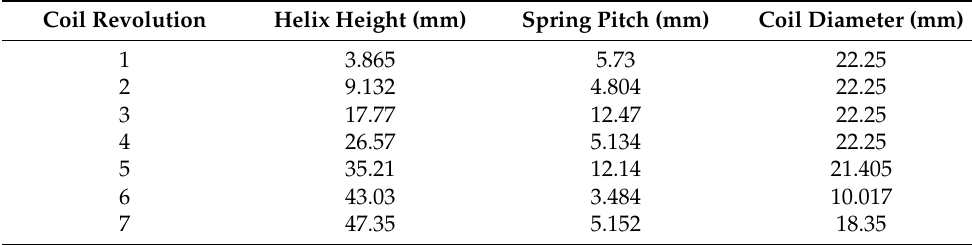
Figure 2. ( a ) The beehive spring sample. ( b ) The FE model of the beehive spring using the Timoshenko beam element. Table 1. The geometric properties of the beehive spring sample.